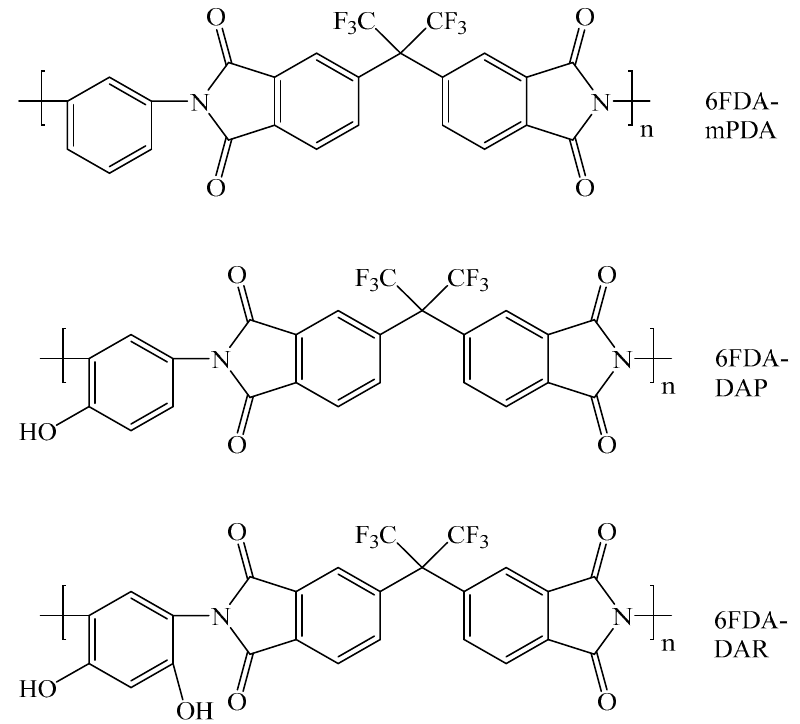
Figure 18. Chemical structures of 6FDA-mPDA, 6FDA-DAP, and 6FDA-DAR.